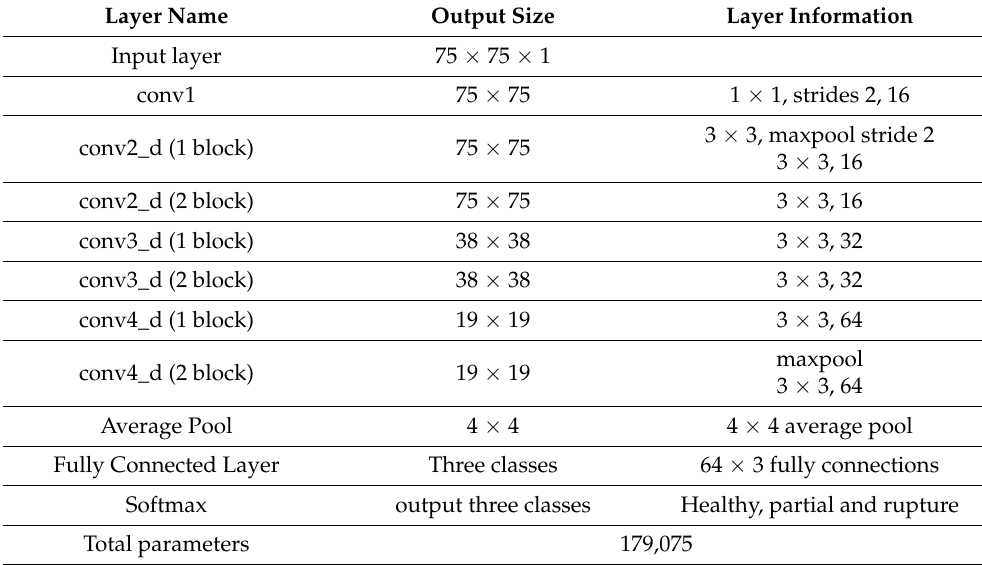
Figure 5. Our customized ResNet-14 architecture. Table 3. The configuration detail of customized ResNet model-14 with their output